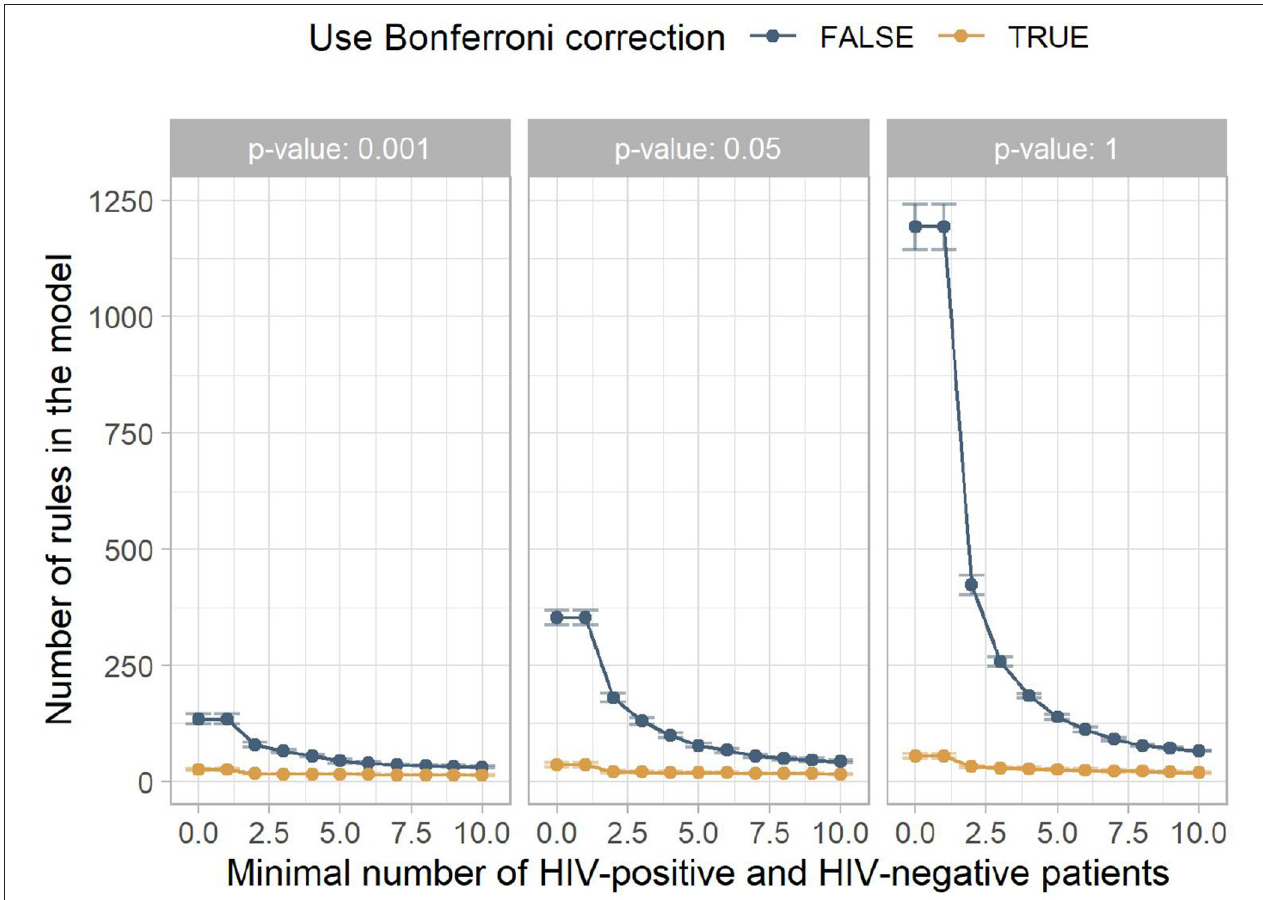
FIGURE 3 | The mean number of rules in the model for the different experiment configurations. The x-axis shows the minimum number of HIV-positive and HIV-negative patients, the facets show different p -value thresholds, the color indicates if Bonferroni correction was used, and the y-axis shows the mean number of rules returned by this configuration, with the error bars indicating plus/minus one standard